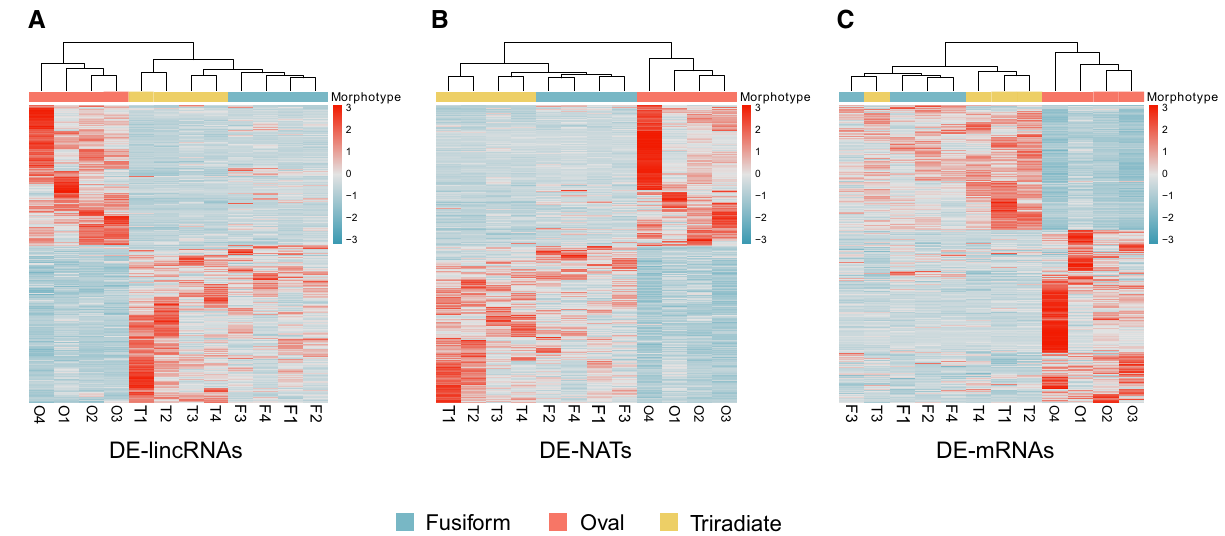
Figure 3. Clustering heatmaps of long noncoding (lincRNA and NAT) and coding transcripts from all three pairwise comparisons (TF, OF, OT). Heatmaps showing multi-group comparison of differentially expressed ( A ) lincRNAs ( B ) NATs, and ( C ) protein-coding transcripts (mRNA) in the three morphotypes. For each heatmap, the set of DE transcripts was taken as the union of DE transcripts of the three pairwise comparisons: T versus F, O versus F, and O versus T. DE transcripts are grouped by hierarchical clustering using the “complete” method and the “Euclidean” distance metric. The heatmaps were produced using the pheatmap R package. Figures were made using the “Wes Anderson” color palette “Zissou1” in R (https:// github. com/ karth ik/ wesan